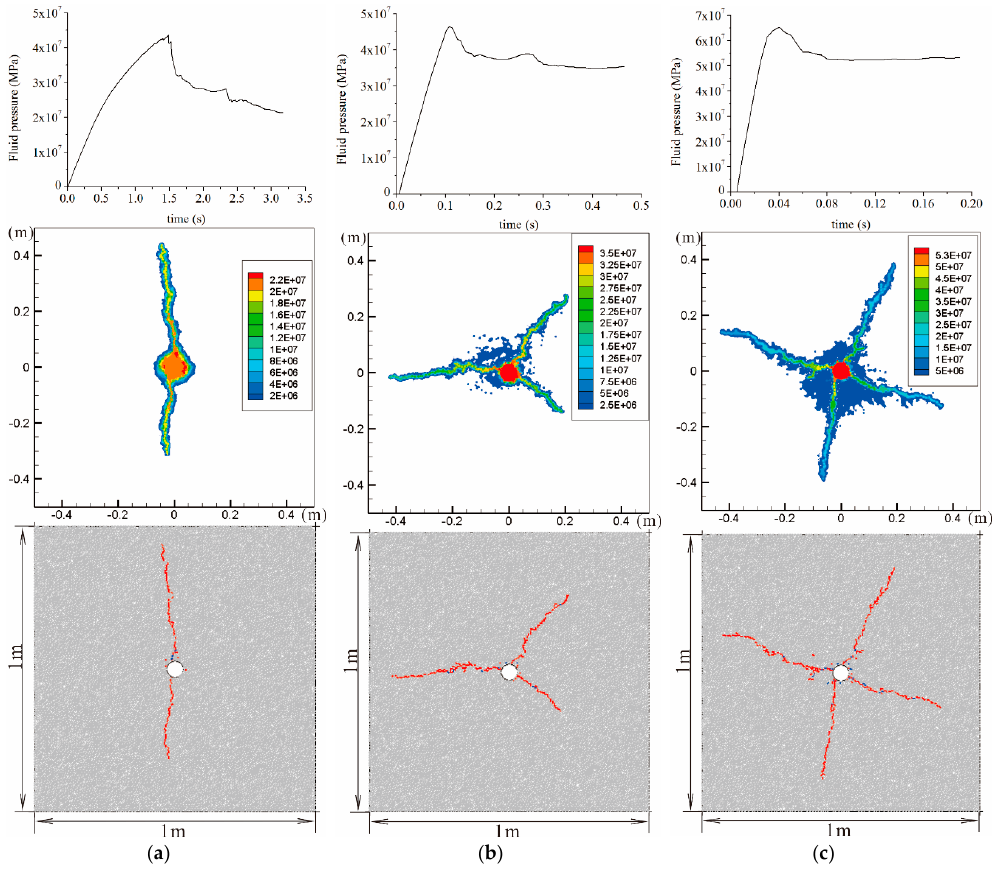
Figure 11. Borehole pressure histories and crack distribution with corresponding fluid pressure in hydraulic fracturing with a fluid viscosity of 1.0 × 10 − 3 Pa · s under di ff erent injection rates: ( a ) 1.0 × 10 − 5 × 10 − 3 Pa · s under different injection rates: m 3 /s; ( b ) 1.0 × 10 − 4 m 3 /s; and ( c ) 5.0 × 10 − 4 m 3 /s. in hydraulic fracturing with a fluid viscosity of 1.0 ( a ) 1.0 × 10 − 5 m 3 /s; ( b ) 1.0 × 10 − 4 m 3 /s; and ( c ) 5.0 × 10 − 4 m 3